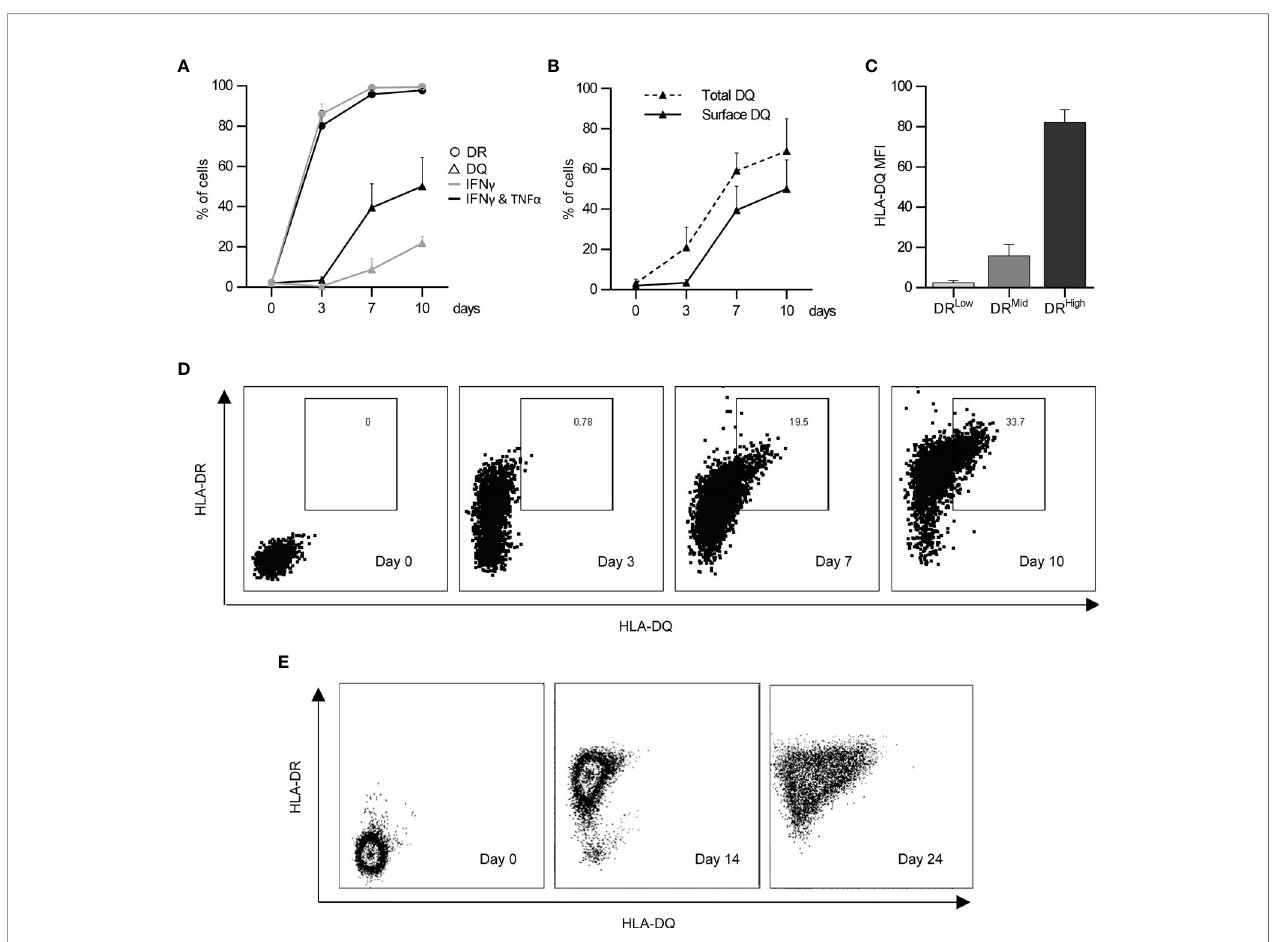
FIGURE 1 | Induction of HLA-DQ protein expression by endothelial cells under in fl ammatory conditions. HLA-DR (circles) and HLA-DQ (triangles) expression was monitored over the course of 10 days in human microvascular endothelial cells (HMEC) stimulated either with IFN g for 3 days (IFN g ; grey lines) or with IFN g for 4 days followed by 3 days of IFN g and TNF a (IFN g & TNF a ; black lines) (n = 3; mean +/- SEM) (A) . HLA-DQ detected at the cell surface (solid line) was compared to total HLA-DQ detected in permeabilised cells (dashed line) (n = 3; mean +/- SEM) (B) . The coexpression of HLA-DR and HLA-DQ was characterised in cells stimulated with IFN g and TNF a as previously described at day 7 (C) (n = 3; mean +/- SEM). (D) shows a representative experiment examining co-expression of HLA-DR and HLA-DQ over a 10 day period in HMEC, whilst (E) shows a representative experiment examining HLA-DR and HLA-DQ expression by primary human renal glomerular endothelial cells after IFN g and TNF a stimulation for 0, 14 and 24